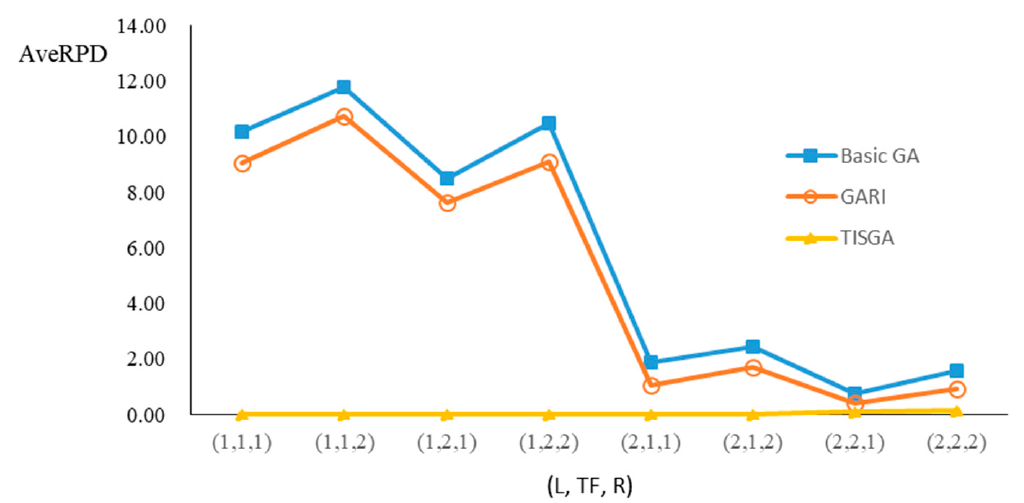
Figure 23. Comparison results for n = 500 with eight combinations of (L, TF, R).